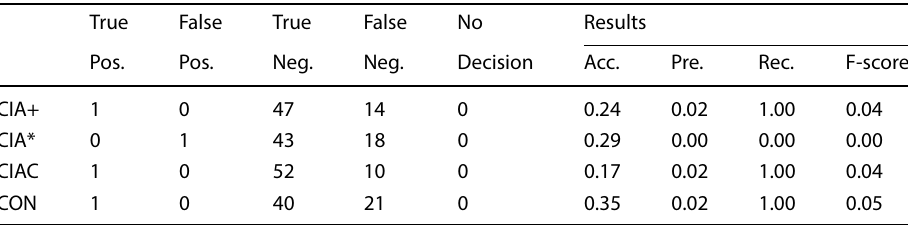
Table 9 Binary classifications and results: information leakage data set